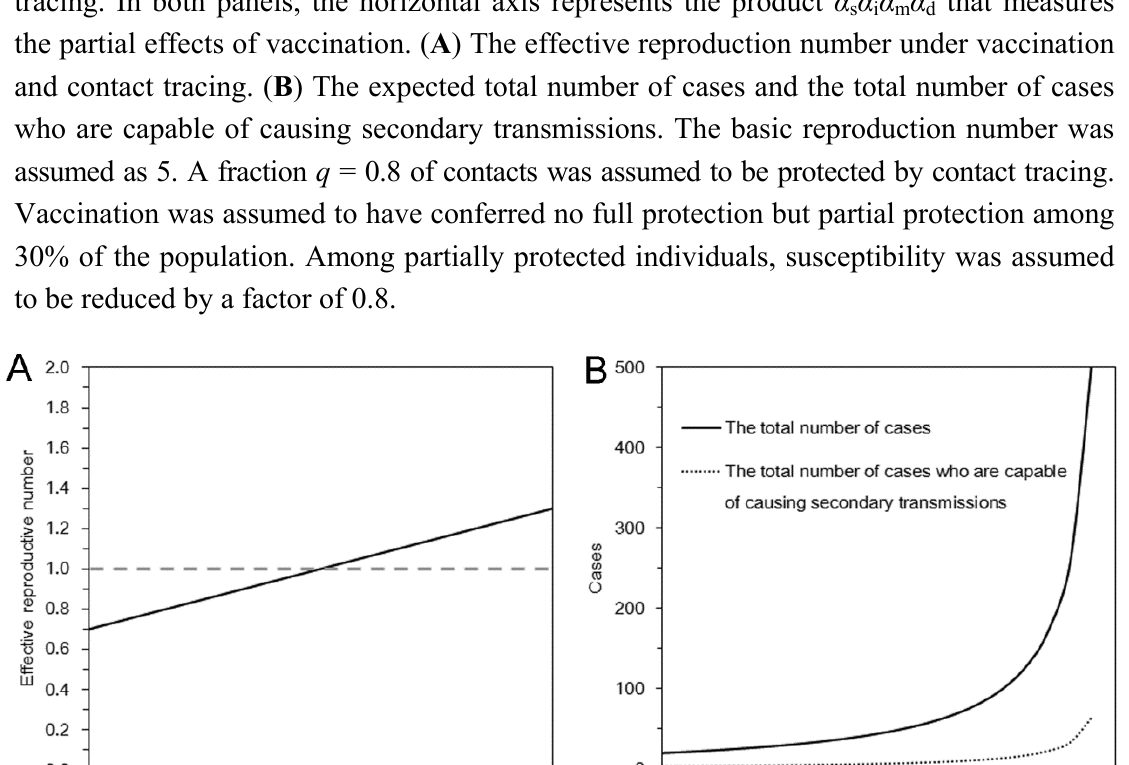
α α α that measures s i m d